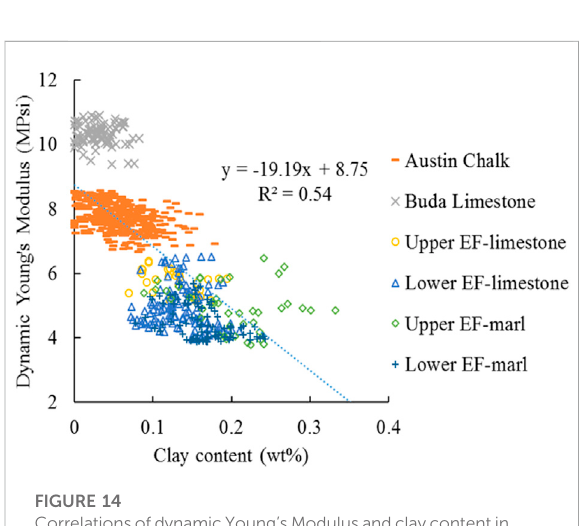
FIGURE 14 CorrelationsofdynamicYoung ’ sModulusandclaycontentin different